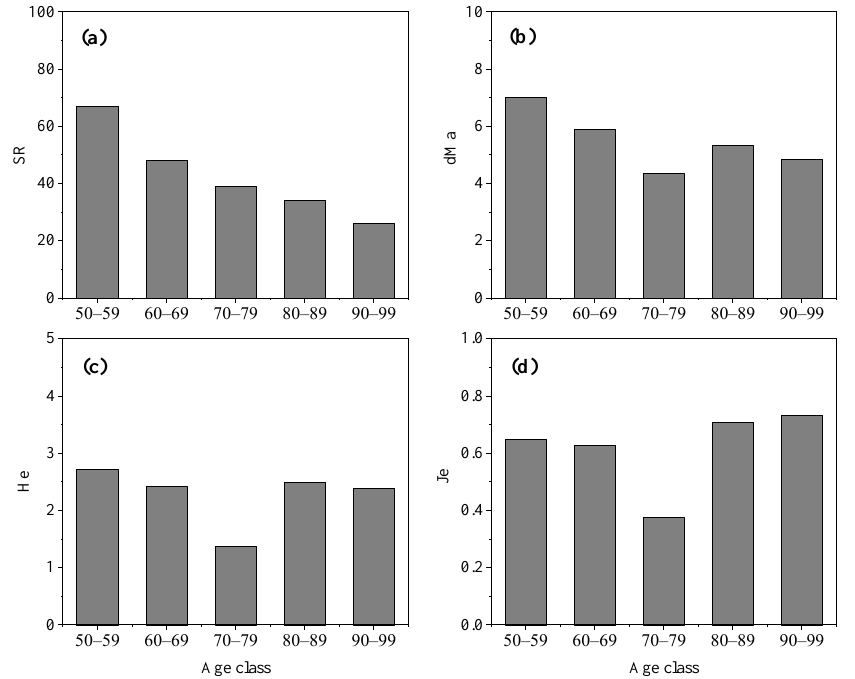
Figure 3. Diversity characteristics of middle-aged trees among different mean age classes in Changchun city. ( a ) SR, species richness; ( b ) dMa, Margalef richness index; ( c ) H e , Shannon–Wiener index; ( d ) J e , evenness index.